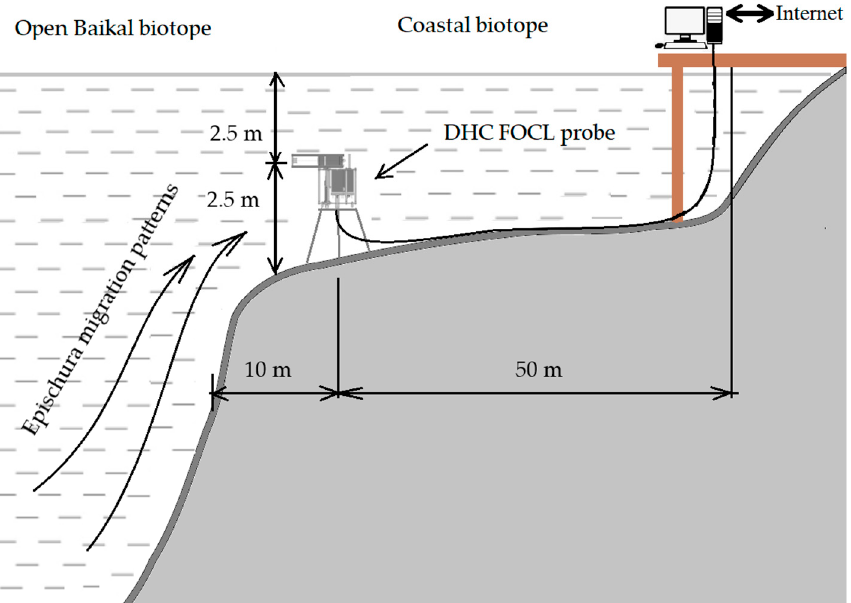
Figure 3. General layout and installation diagram of the DHC FOCL probe in Lake Baikal, Bolshiye Koty settlement, LIN SB RAS research station at the point with coordinates 51 ◦ 53,952 (cid:48) N 105 ◦ 03,834 (cid:48)